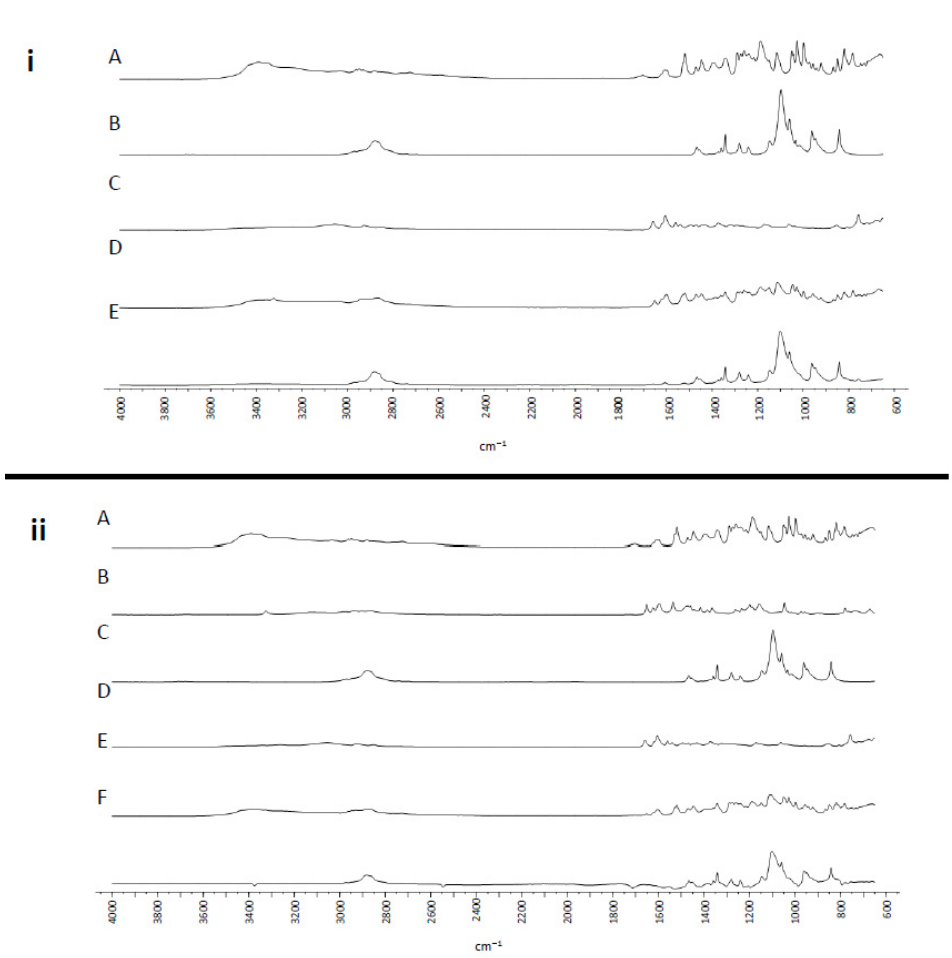
Figure 2. ( i ) P68 + DQA HT. FTIR spectra for ( A ) HT, ( B ) P68, ( C ) DQA, ( D ) a physical mixture of P68, DQA and HT in the same ratio as the nanoformulation and ( E ) lyophilized P68 + DQA HT nanoformulation. ( ii ) P68 + DQA HT + DFO. FTIR spectra for ( A ) HT, ( B ) DFO, ( C ) P68, ( D ) DQA, ( E ) a physical mixture of P68, DQA, HT and DFO in the same ratio as the nanoformulation and ( F ) lyophilized P68 + DQA HT + DFO nanoformulation.